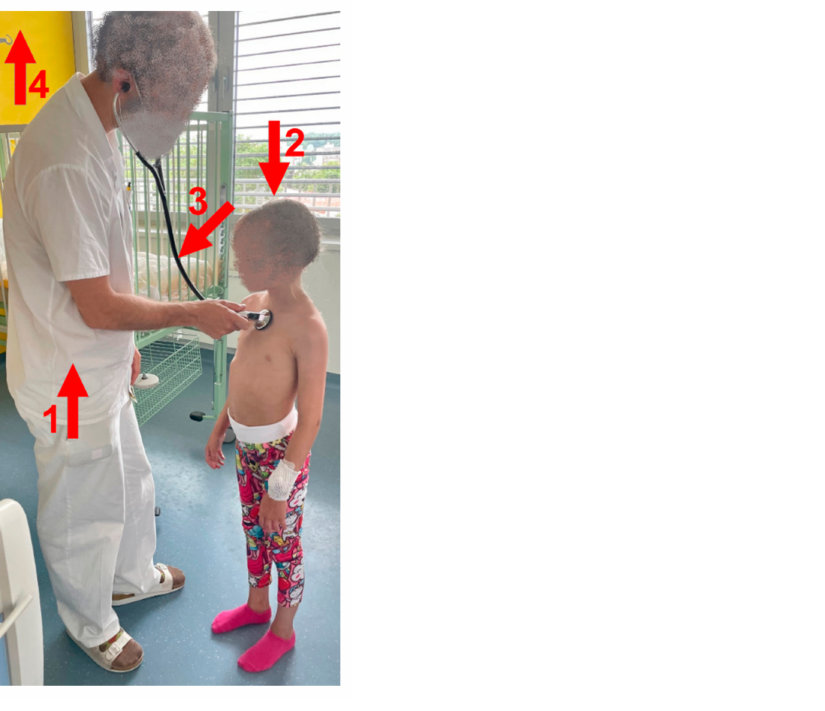
Figure 1. Measurement scheme: 1—the physician, 2—the patient, 3—the measuring device phonen- doscope Littmann 3200, 4—the soundproof room preventing entry of the noise from the surroundings (illustrative